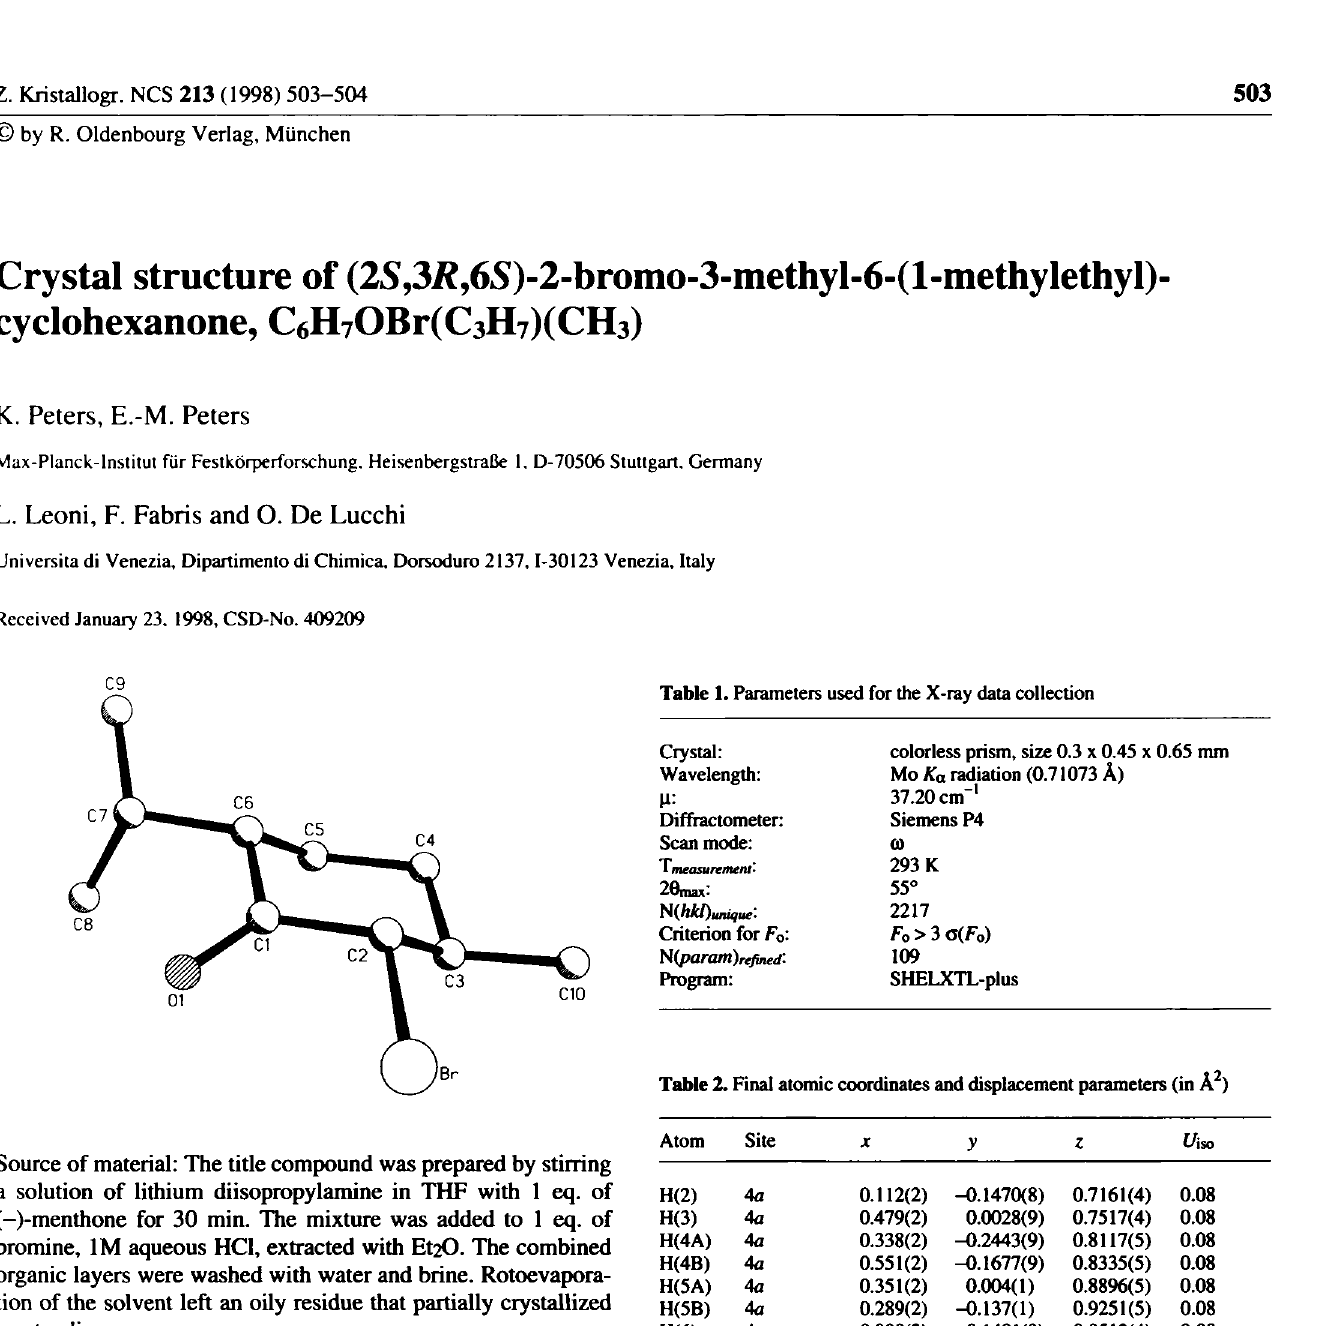
Table 3. Final atomic coordinates and displacement parameters (in h?)